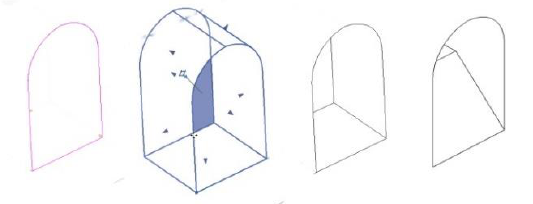
Figure 8. Modelling of windows in the central nave.